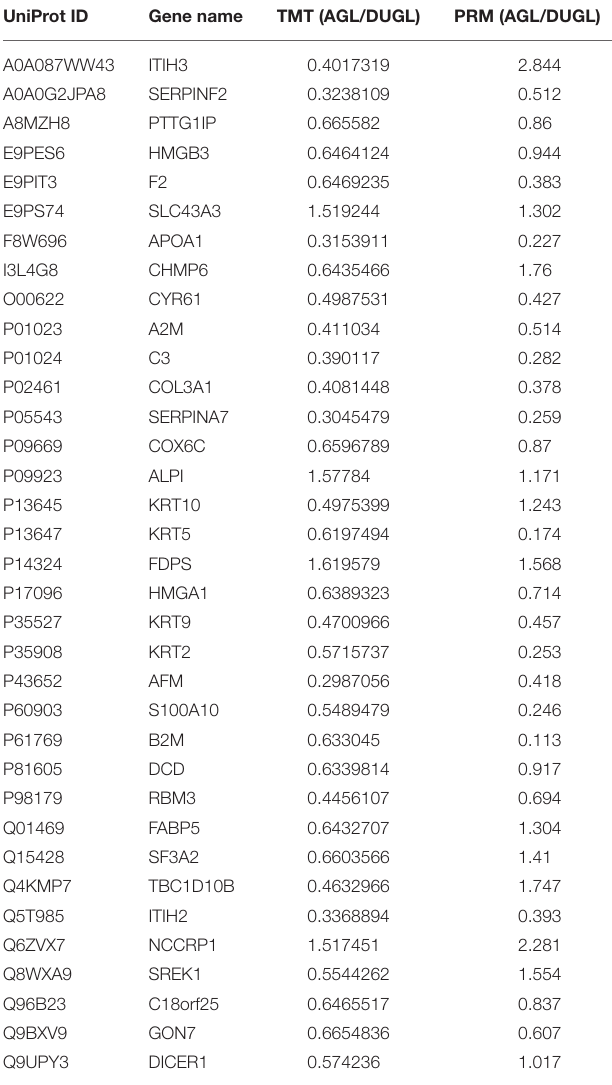
TABLE 2 | Results of DAP verification by parallel reaction monitoring. UniProt